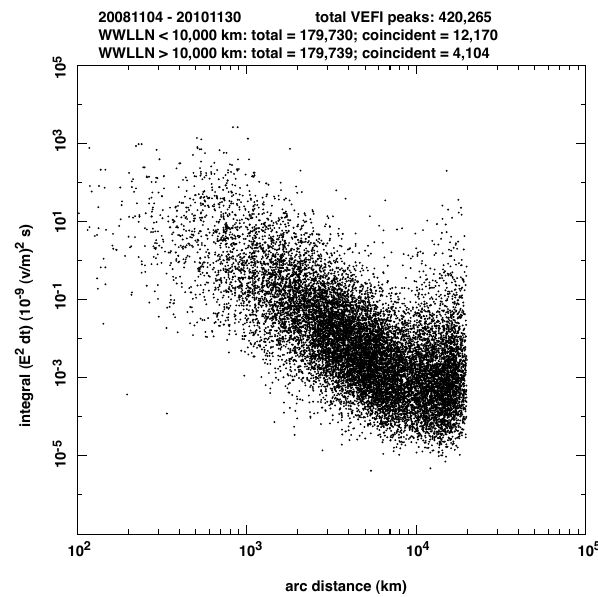
Fig. 16. Scatter plot of the integral of E 2 at the satellite vs. arcdis- tance to the coincident WWLLN stroke